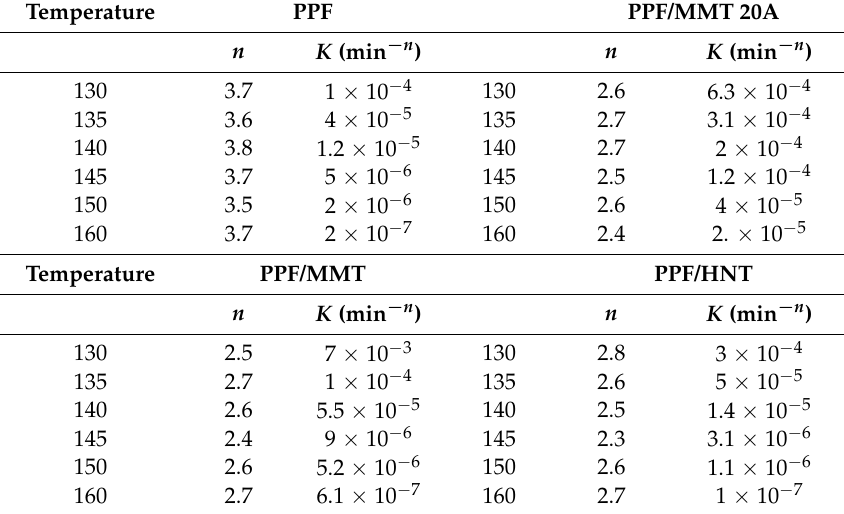
Figure 7. Avrami plots for the isothermal crystallization of PPF and PPF-MMT samples. Table 1. Avrami parameters; n and K , obtained from fitting the experimental data from isothermal crystallization for PPF and nanocomposites, with the Avrami equation.